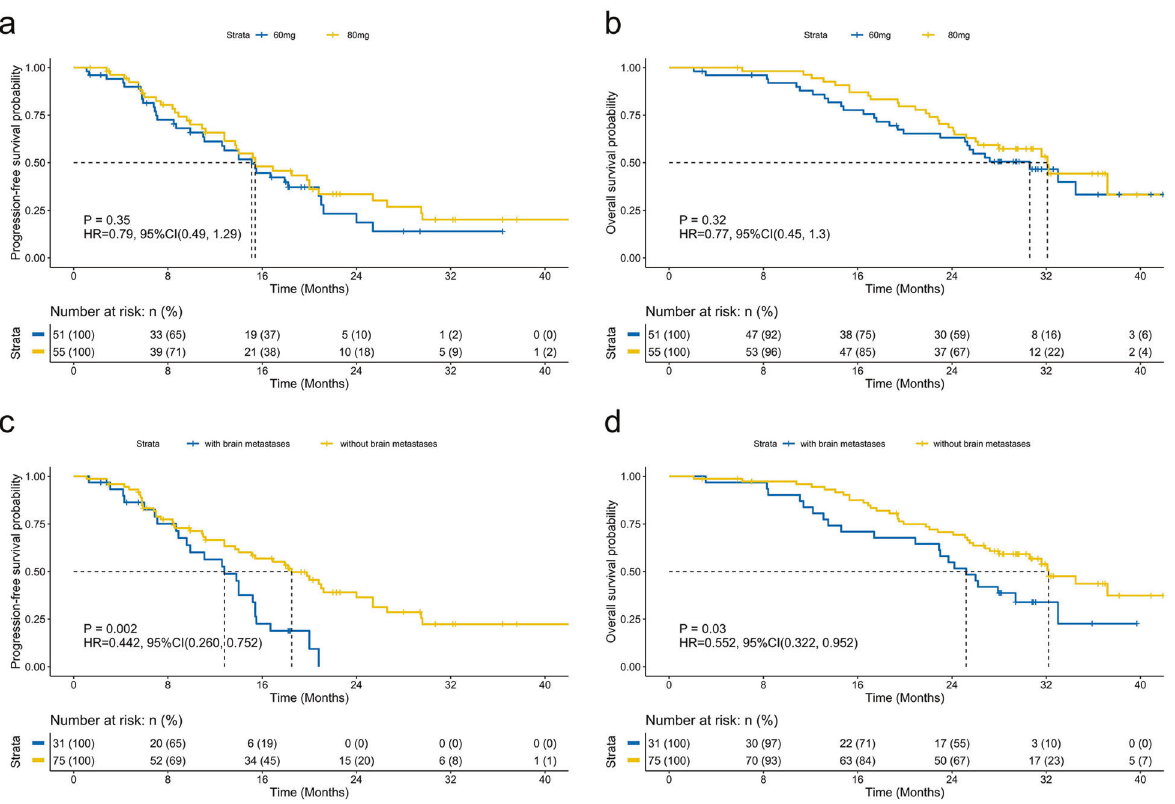
Fig. 1 Survival outcomes with mefatinib were similar for patients who received mefatinib at 60 and 80 mg but were signi fi cantly different based on brain metastatic status at presentation. Kaplan – Meier curves comparing the progression-free survival ( a , c ) and overall survival ( b , d ) of patients with advanced EGFR – mutant non-small-cell lung cancer who received mefatinib as fi rst-line therapy at a daily dose of either 60 mg or 80 mg ( a , b ) or based on brain metastatic status at presentation ( c , d